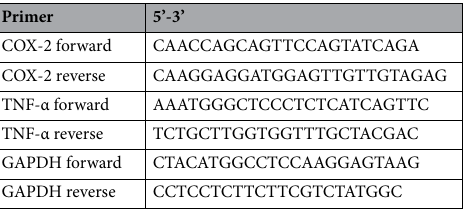
Table 1. Primer sequences of COX‑2 , TNF‑α , and the housekeeping genes. COX‑2 Cyclooxygenase-2, TNF‑α Tumor necrosis factor-α, GAPDH Glyceraldehyde 3-phosphate